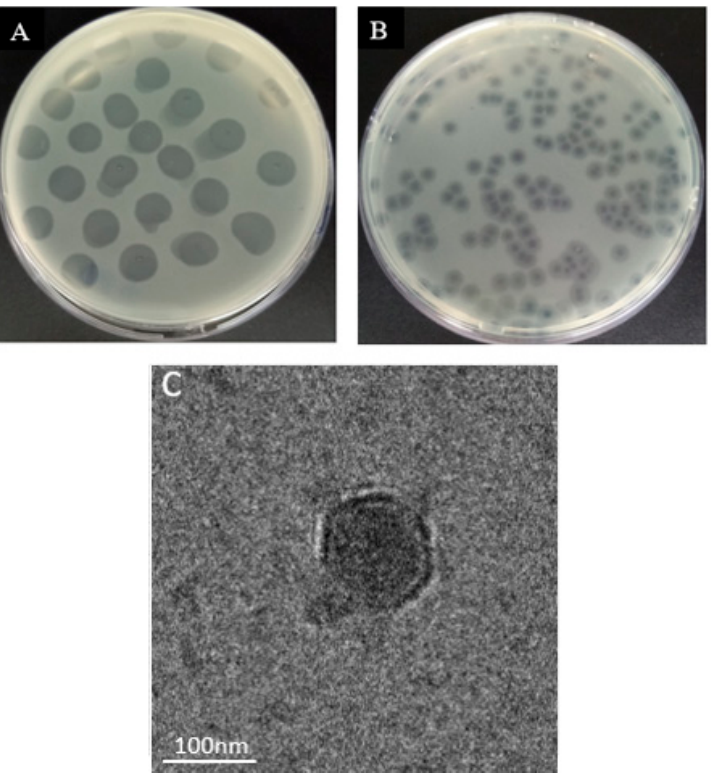
Figure 2 . ( A ) Spot assay (lytic zone on the lawn of P. aeruginosa strain B10); ( B ) typical vB_PseuP- SA22 plaques; and ( C ) transmission electron micrograph of vB_PseuP-SA22 under negative stain- ing with 2% uranyl acetate. The size of petri plates = 90 mm; bar = 100